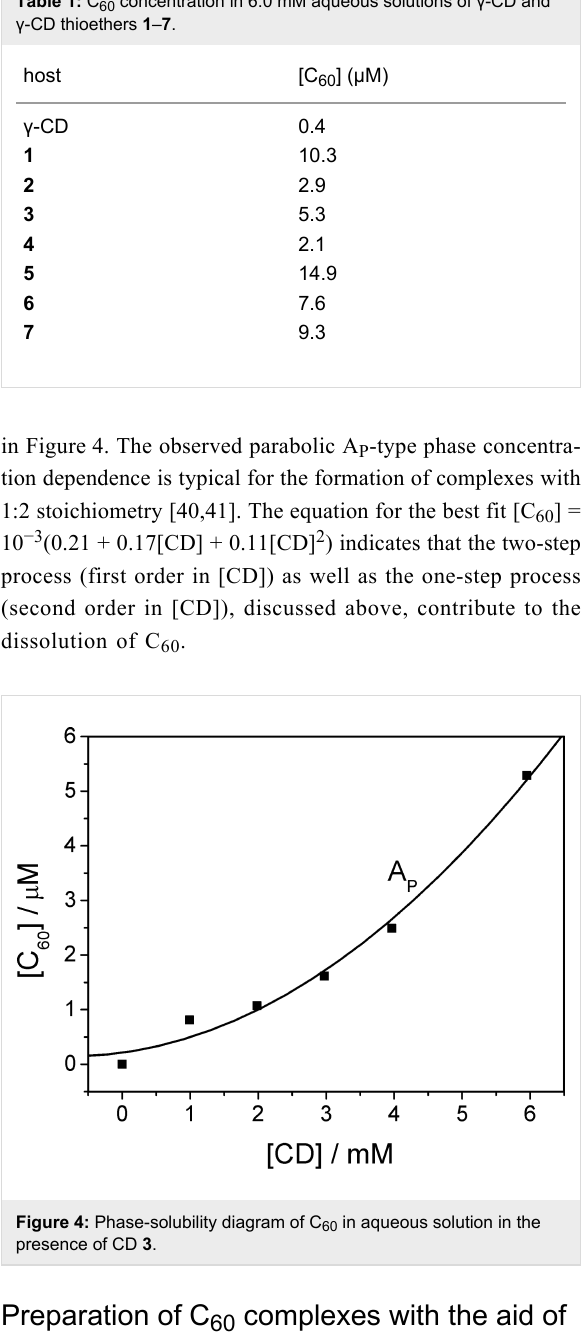
Preparation of C organic